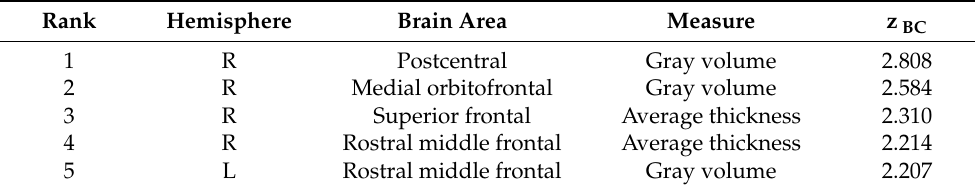
Table 3. Top-ranking brain features of betweenness centrality (Cluster I).